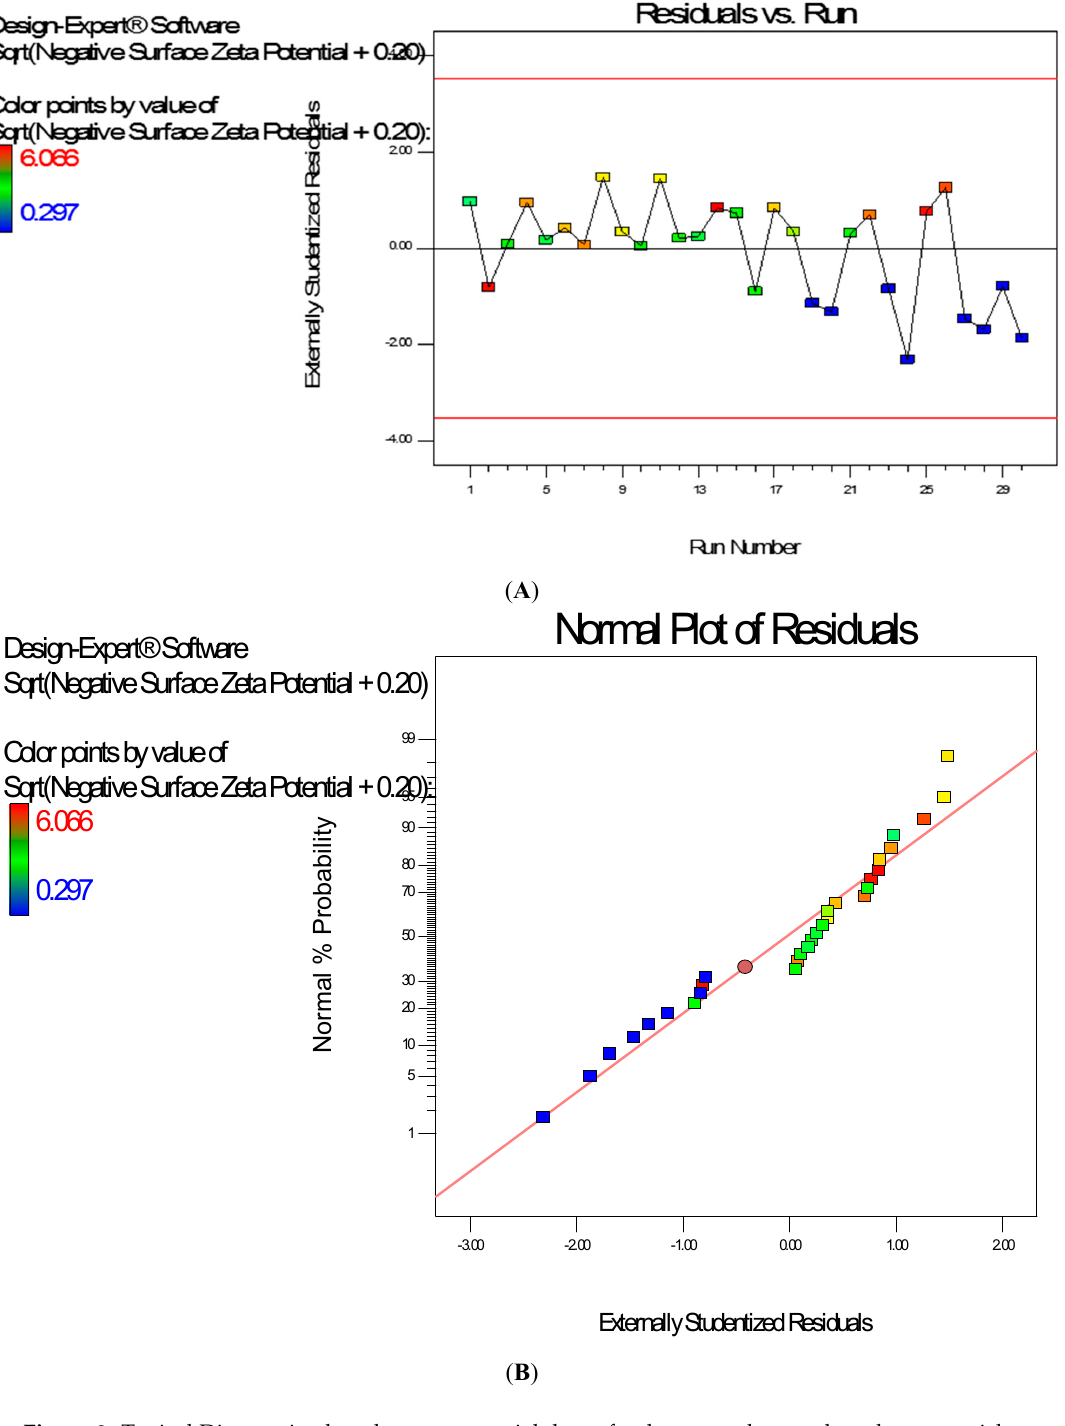
Figure 8. Typical Diagnostic plots the zeta potential data of poly- ɛ -caprolactone-based nanoparticles ( A ) Residuals vs. Experimental Run (should show a random scatter); ( B ) Normal Plot of Residuals (should give a straight line).